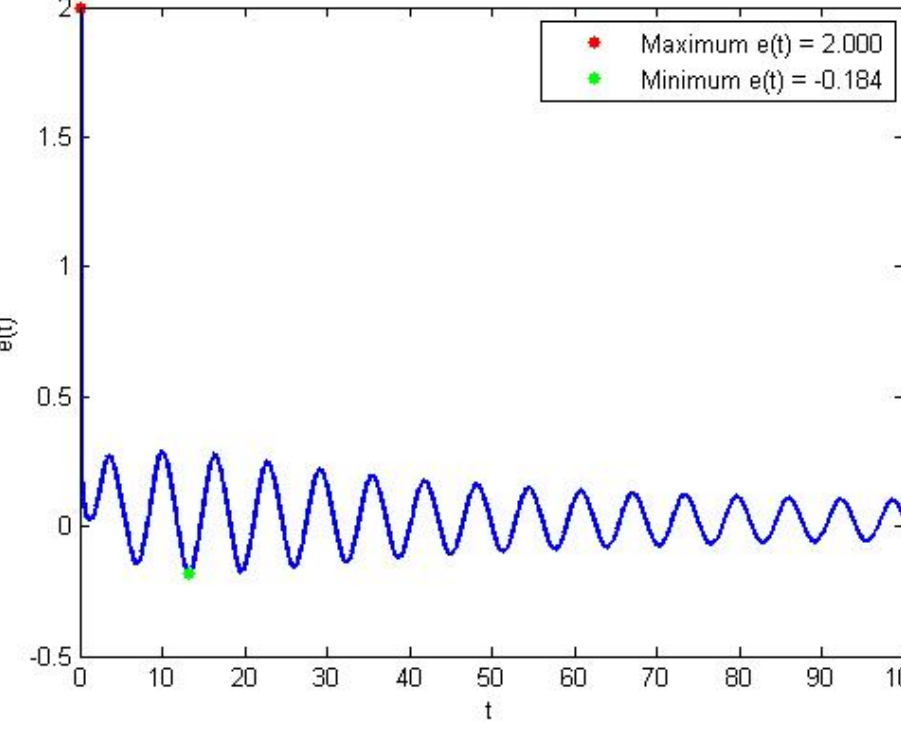
Figure 7. e ( t ) for system (7), with α = 0.7, ρ = 0.5, and w ( t ) = [ 2 sin ( t )] T .